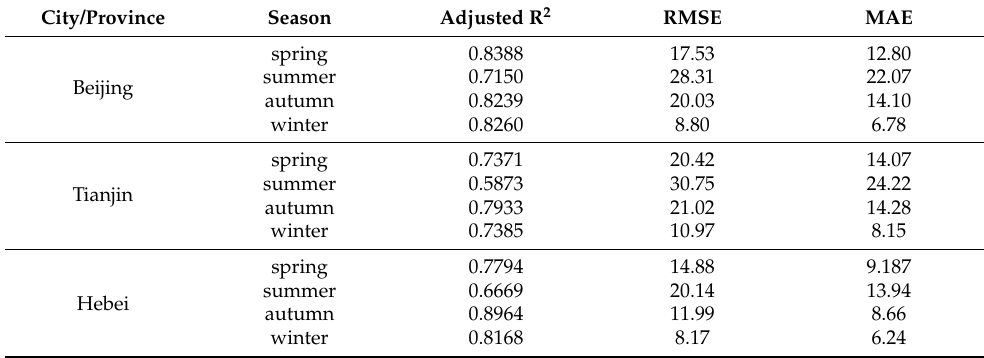
Table 7. Performance of the ANN on O 3 concentration simulation in different seasons using the optimal network